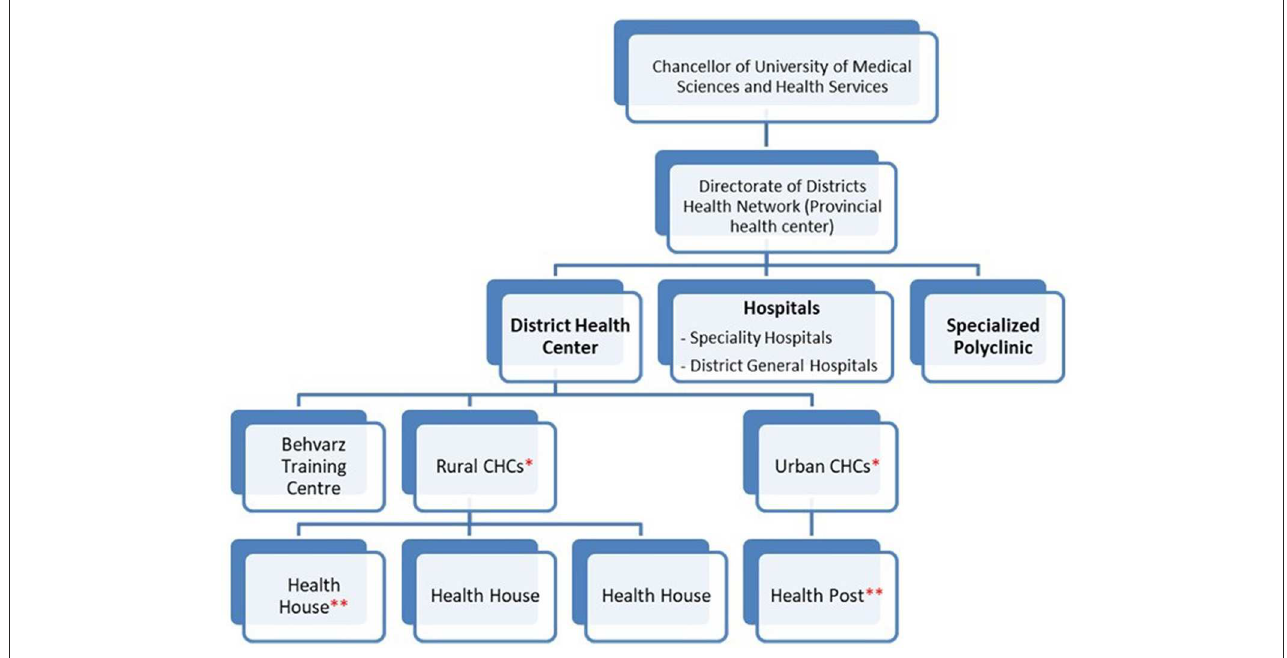
FIGURE1 The structure of Iran’s health system in each province. *Each rural CHC covers almost 8,000 people, whereas an Urban CHC covers ∼ 37,500 people. **Each Health House serves almost 1,000 rural people, while each Health Post provides services for 12,500 city dwellers.